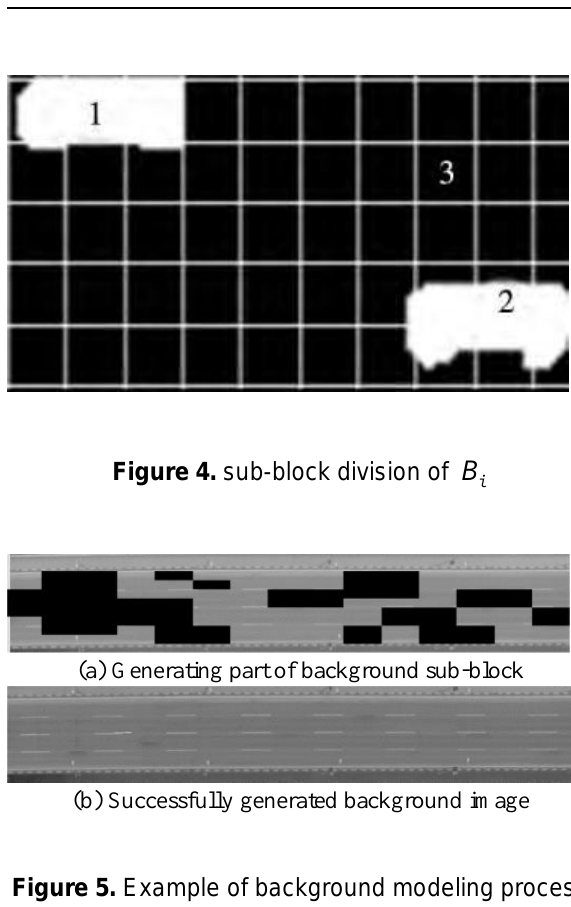
Figure 5. Example of background modeling